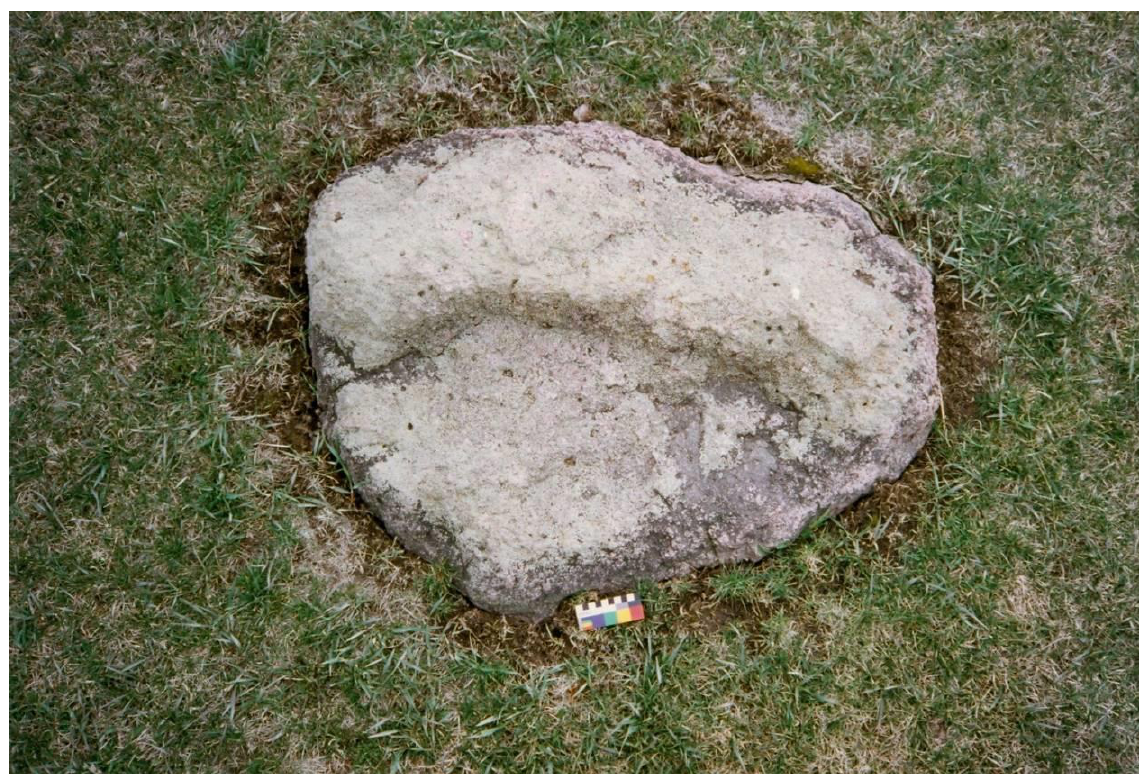
Figure 24. A direct, overhead view of the Star-Being headstone showing its dual humps and flat, cleaved straight rear end.